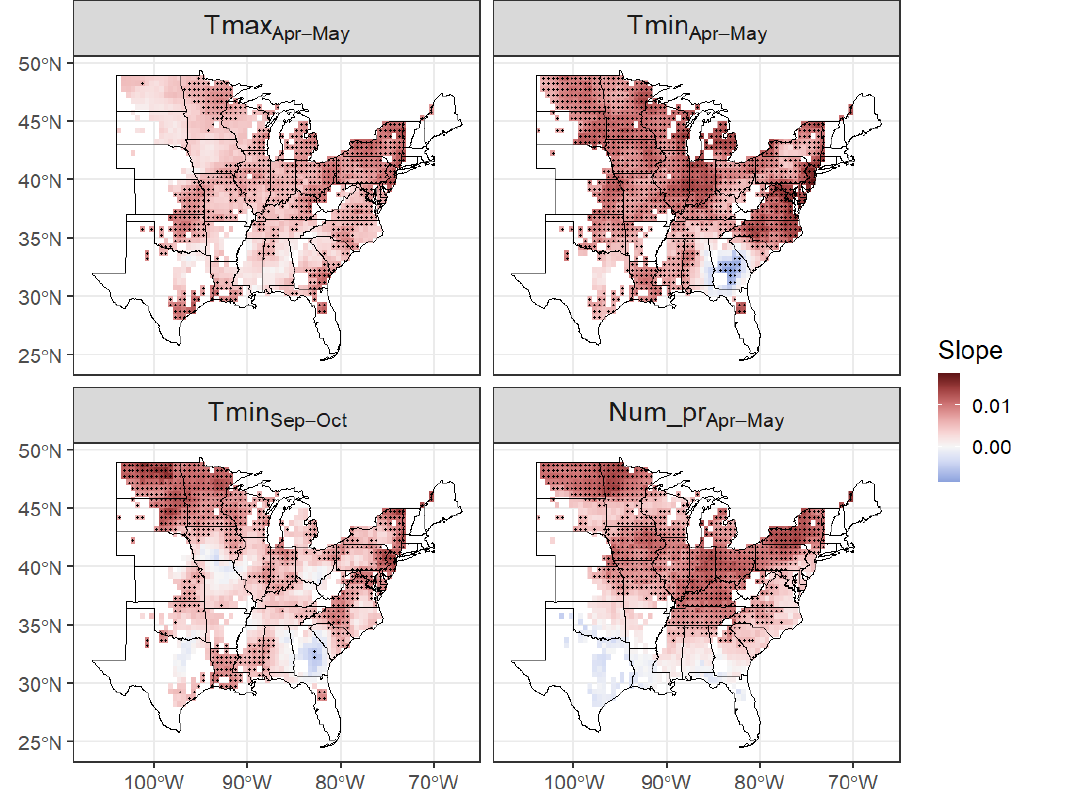
Figure A5. Linear trends for the main identified drivers of soybean yield variability over the 1946–2016 period. The stippling indicates statistical significance at the 95% confidence level. Trends for moisture and temperature variables over summer are displayed in the main text.